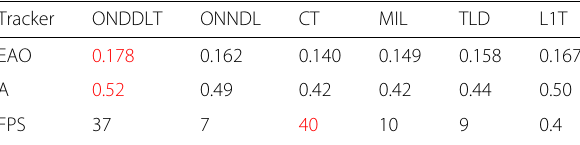
Table 2 Comparison in terms of expected average